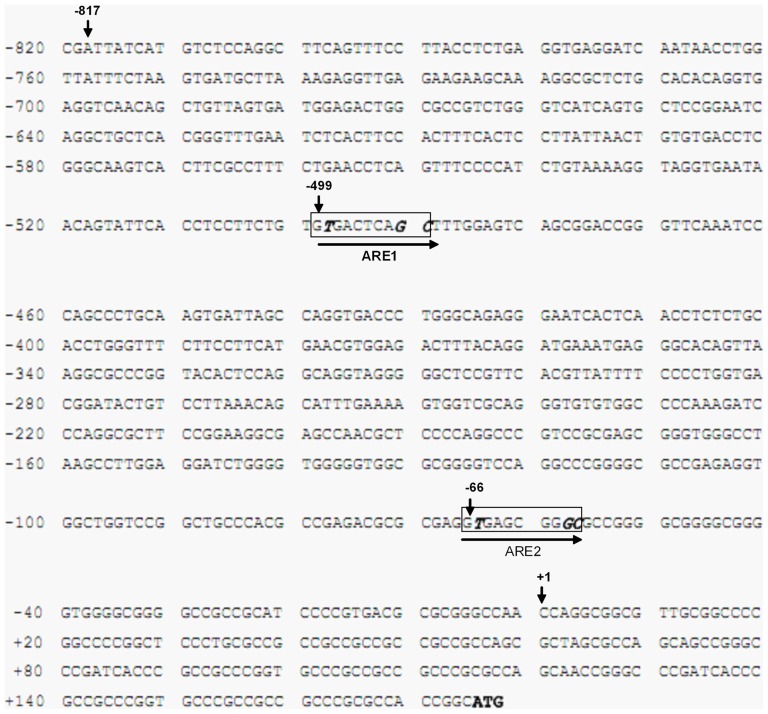
Nucleotide sequence of the 5′-flanking region of the hMrp1 gene containing two potential ARE sites.Nucleotides were numbered relative to the transcription start site (+1). The translation initiation codon (ATG) was in bold. Boxed region indicated ARE1 and ARE2 respectively. The nucleotides to be mutated in this study were in bold italic.